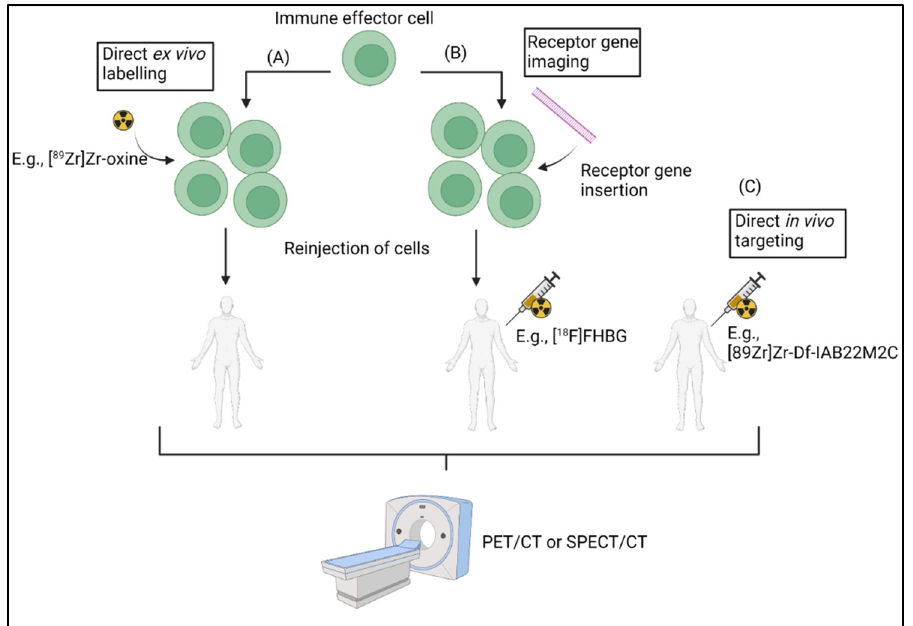
Figure 1. Schematic illustration representing the different methods to image immune cells with PET and SPECT radiopharmaceuticals. ( A ) direct ex vivo labelling, ( B ) receptor gene imaging and ( C ) direct in vivo targeting. Created with Biorender.com.